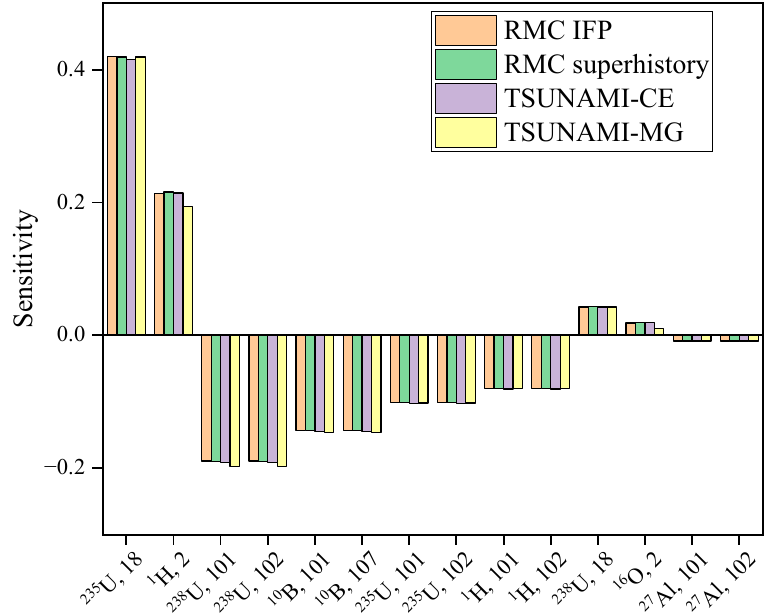
Figure 4. B&W’s Core XI Partial Nuclide Sensitivity.